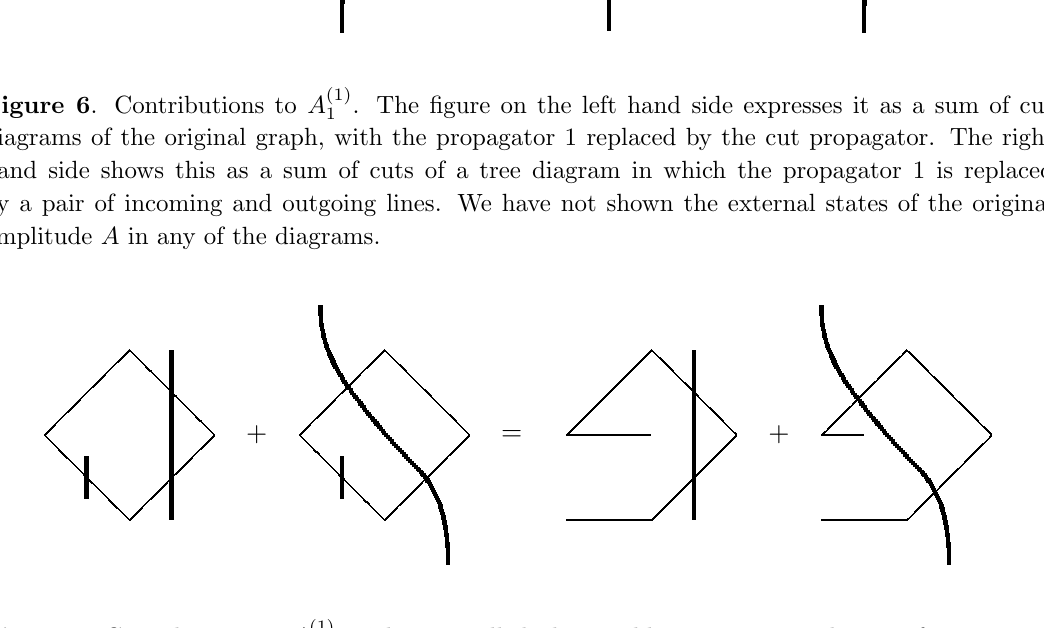
. Unless cancelled, this would represent contributions from anoma- 2